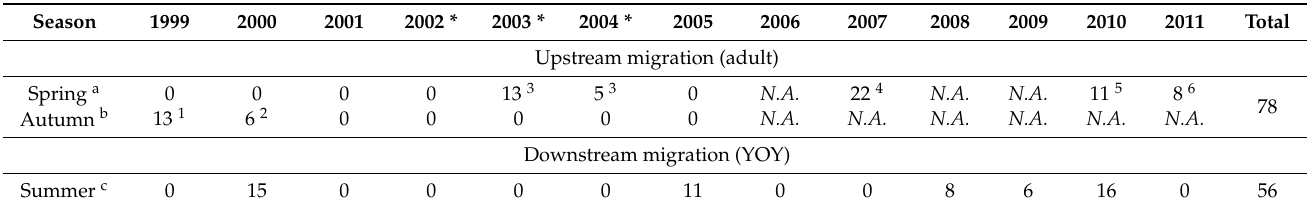
Figure 1. Sampling site locations along the lower Danube River and corresponding pie charts showing the frequency distribution of mtDNA composite haplotypes across the study area. ( 1 Sf â ntu Gheorghe Branch has its RKM notation, different from Danube River, from RKM 0 to RKM 110; 2 Borcea Branch has its RKM notation, different from Danube River, from RKM 0 to RKM 100). Table 1. Sampling sites of stellate sturgeon individuals along the lower Danube River, and the number of spring and autumn adult migrants and YOY individuals captured and sampled for genetic analyses per